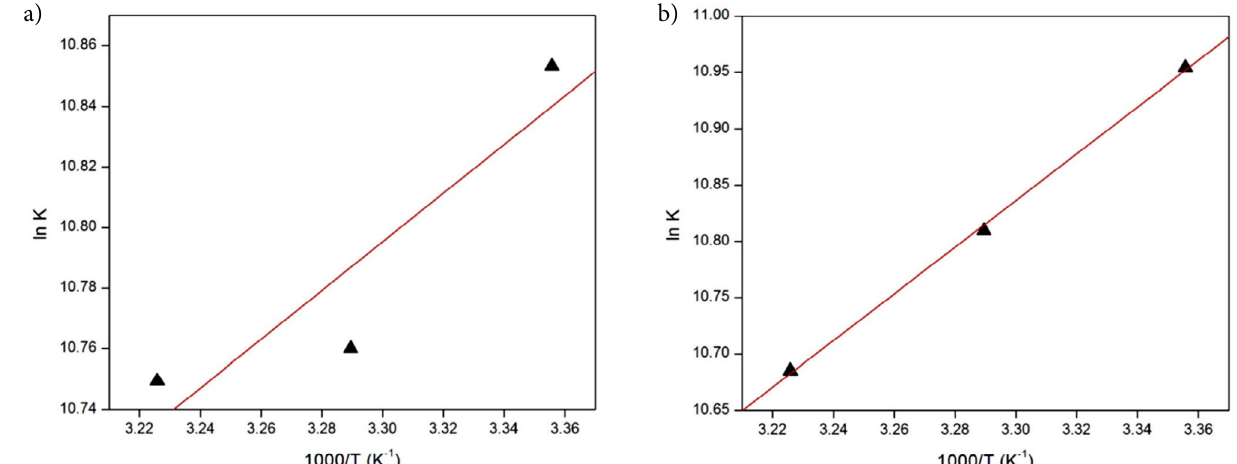
Fig. 8: van’t Hoff plot for the interaction of BSA with (a) MnL complex (b) FeL